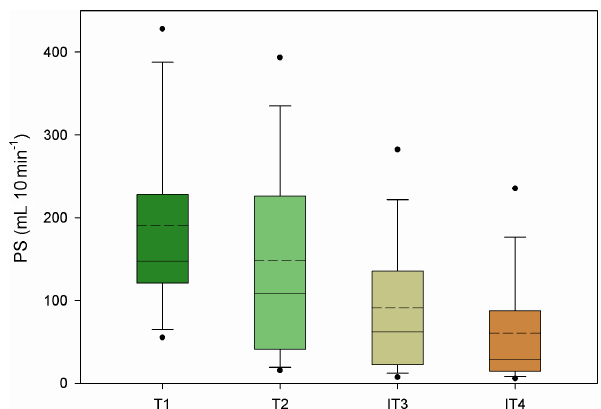
Figure 5. Box plots showing the results of percolation stability (PS) analysis for T1 (near tree trunk), T2 (near tree drip line; within tree area), IT3 (near tree drip line; outside tree area) and IT4 (intertree area between two trees) sampling locations. Median – solid line; mean – dashed line; dots – 5th and 95th